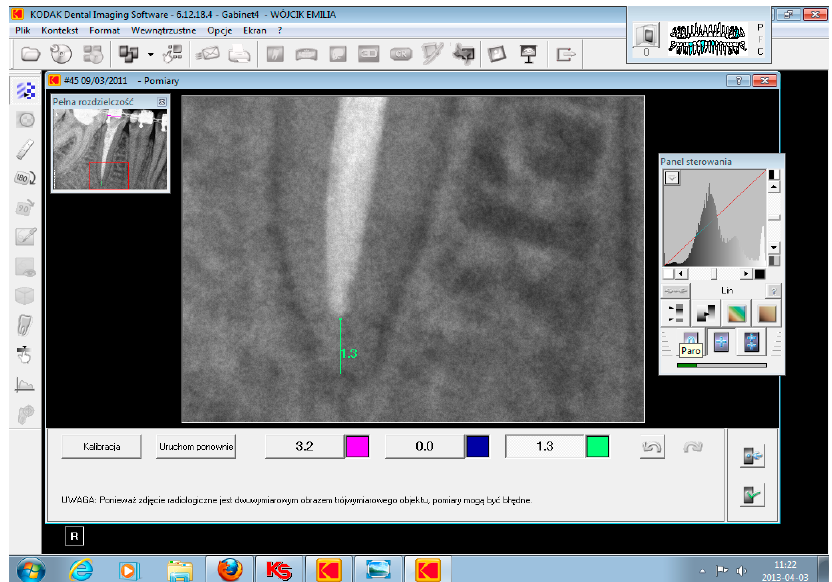
Figure 3. The screenshot of intraoral periapical radiograph (root’s apex magnification) of endodontically treated tooth presenting the measurement of the root canal filling range.